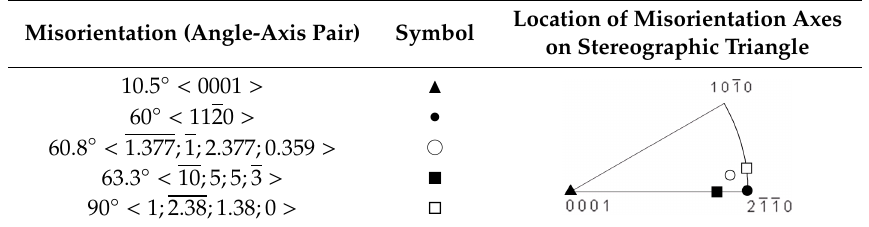
Table 2. Predicted misorientations between α variants inherited from the same parent β grain (after Gey et al. [56] and Wang et al. [57]). Misorientation Location of Misorientation Axes on Misorientation (Angle-Axis Pair) Symbol Stereographic Triangle